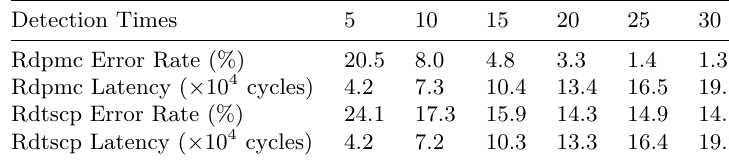
Table 8: Comparison between Branchscope and Bluethunder (detection times = 6). – Bluethunder Branchscope Error Bits 163 47 Error Rate 1.63% 0.47% Attack Overhead 18,532